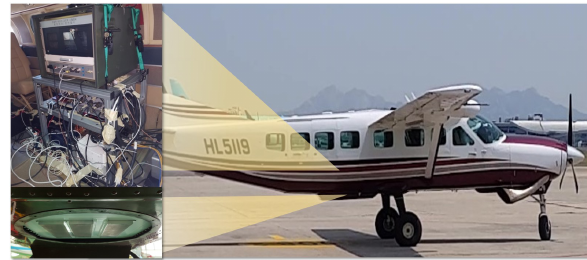
Figure 11. Testbed and proposed AP-TAN for captive flight tests.